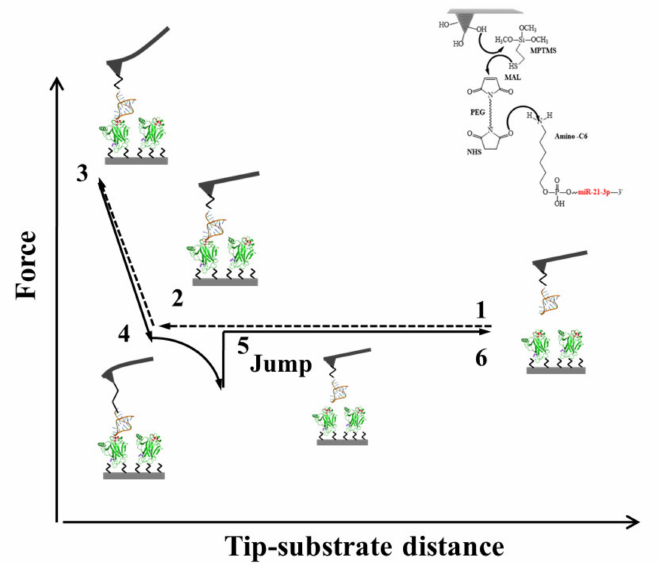
Figure 7. A typical approach–retraction cycle of the miR21-3p-functionalized tip over the DBD- functionalized substrate showing a specific unbinding event. Point 1: The cantilever moves toward the substrate. Point 2: The tip reaches the contact point, with the two partners eventually forming a complex. Point 3: The cantilever further moved toward the substrate, undergoing an upward deflection. Point 4: The cantilever is retracted from the substrate with a bending downward due to attractive interaction forces between the partners. Point 5: The tip undergoes a jump-off with an unbinding of the complex. Point 6: the cantilever returns to its initial